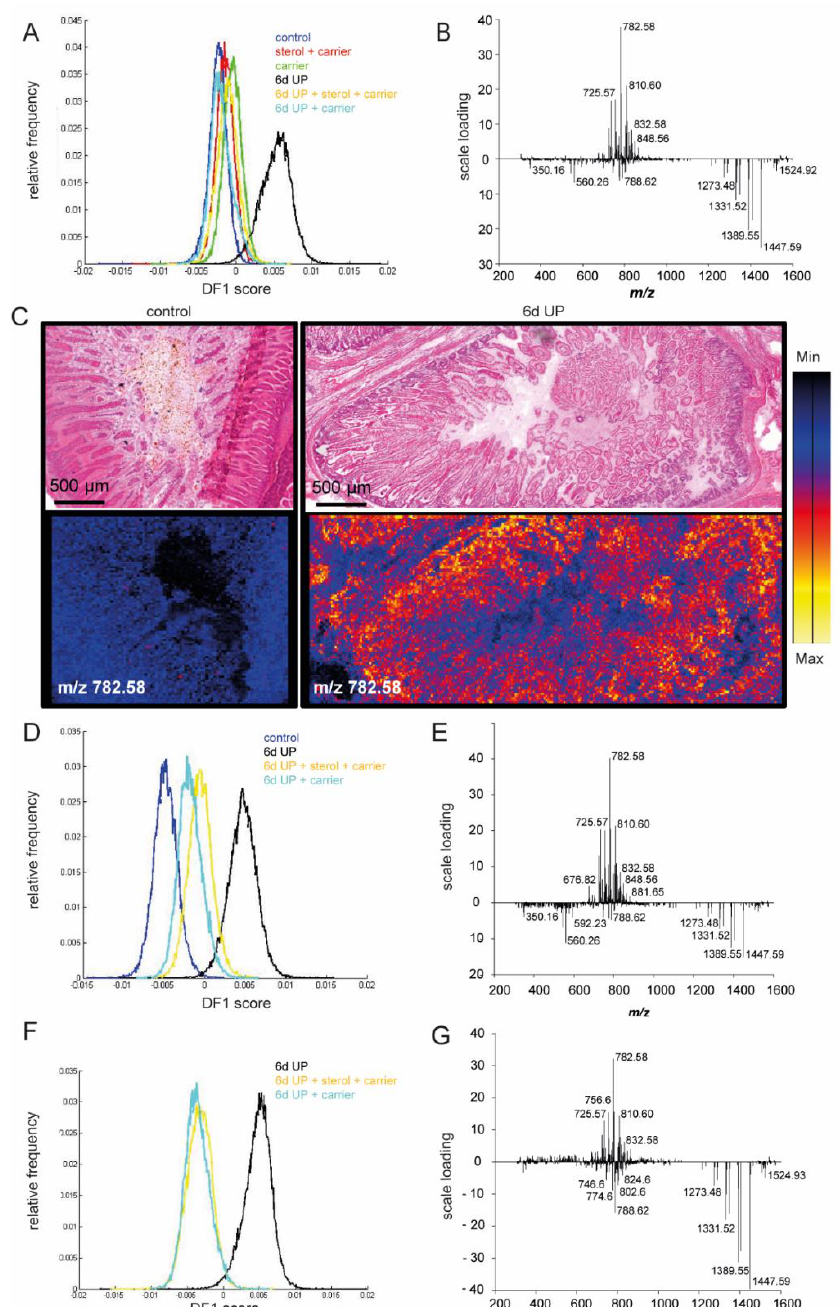
Figure 9. Matrix-assisted laser desorption ionization mass spectrometry imaging performed in positive ion mode followed by principal component analysis. The first discriminant function is shown. (A) Intestinal lipid composition was changed after 6 d UP exposure compared to the other treatment groups, (B, C) with increased presence of different PCs and SMs in the 6-d UP group, including m/z 782.58 PC 34:1 [M+Na]+, m/z 810.60 PC 36:1 [M+Na]+, and m/z 725.57 SM 34:1 [M+Na]+. (D,E,F,G) These UP-induced changes in the intestinal lipidome were partially normalized by plant sterols and/or the carrier. The carrier (2-hydroxypropyl- β -cyclodextrin), characterized by m/z 1331.52 [M+Na]+, m/z 1389.55, and m/z 1447.59, was detected in the intestinal epithelium of the 6-d UP + sterol + carrier and the 6-d UP + carrier groups. Abbreviations: PCs, phosphocholines; SMs, sphingomyelins; UP, U. parvum